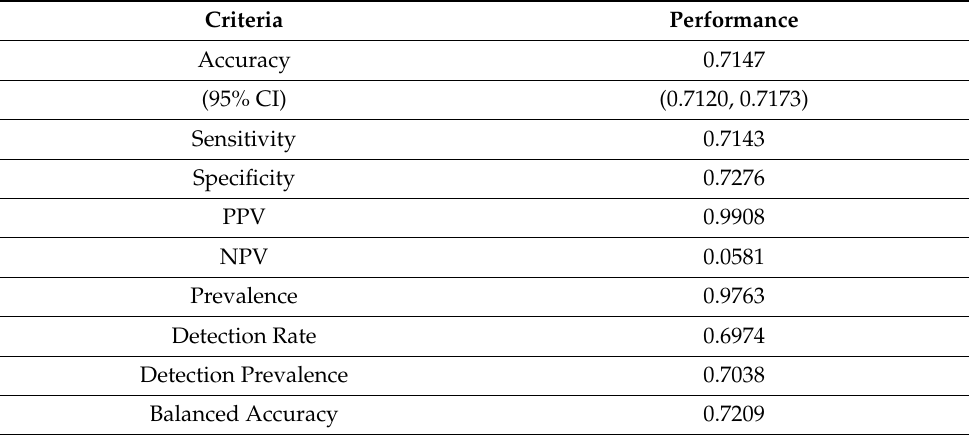
Table 8. XGB model performance in the context of retargeting